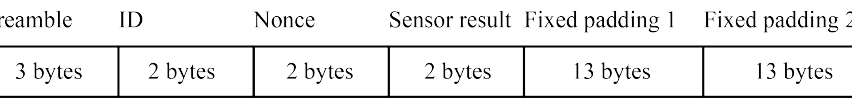
Figure 7. Components of the uplink